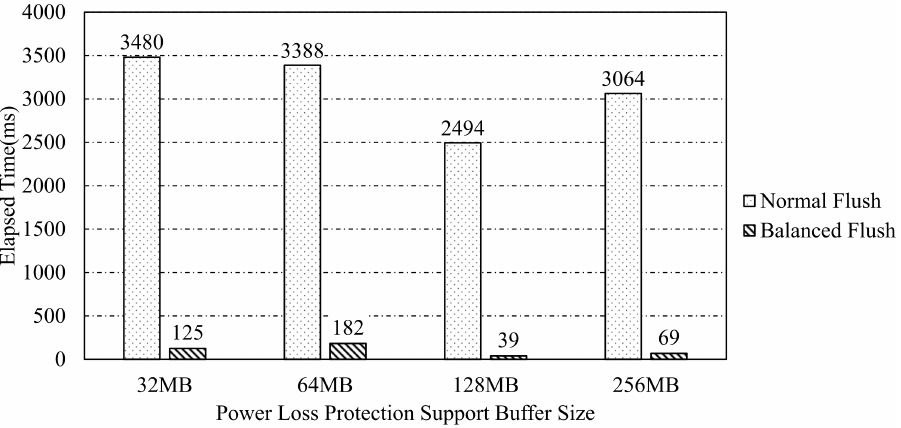
Figure 13. The time taken by PLP with varying PLP buffer